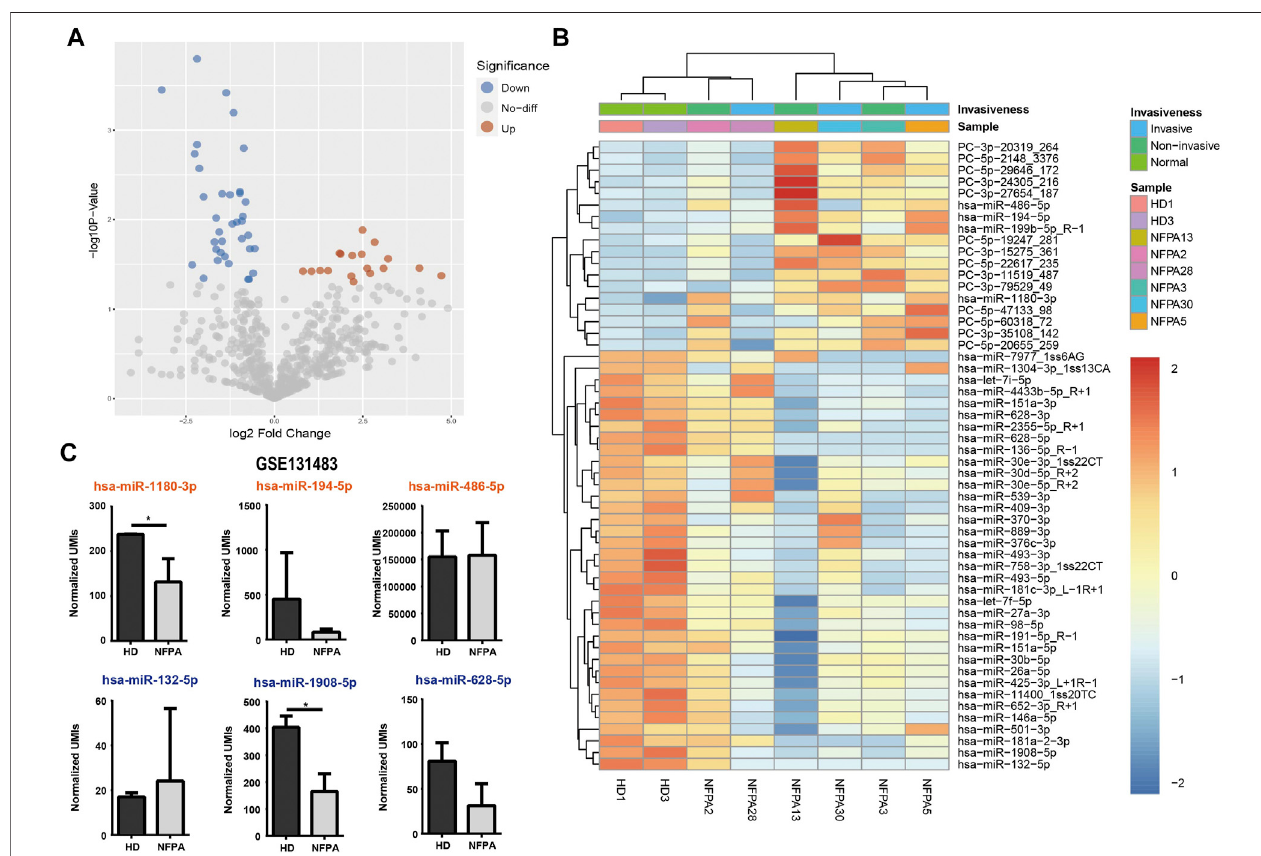
FIGURE2| Differentialexpression analysisofexosomalmiRNAs.Volcanoplot (A) and heatmap (B) showedthe54DE-miRNAsinNFPAsandHDs. (C) Circulating miRNAdataset (GSE131483) was reanalyzed for comparison of exosomal miRNA and circulatingmiRNA(orange:up-regulated in exosome; dark blue: down-regulated in